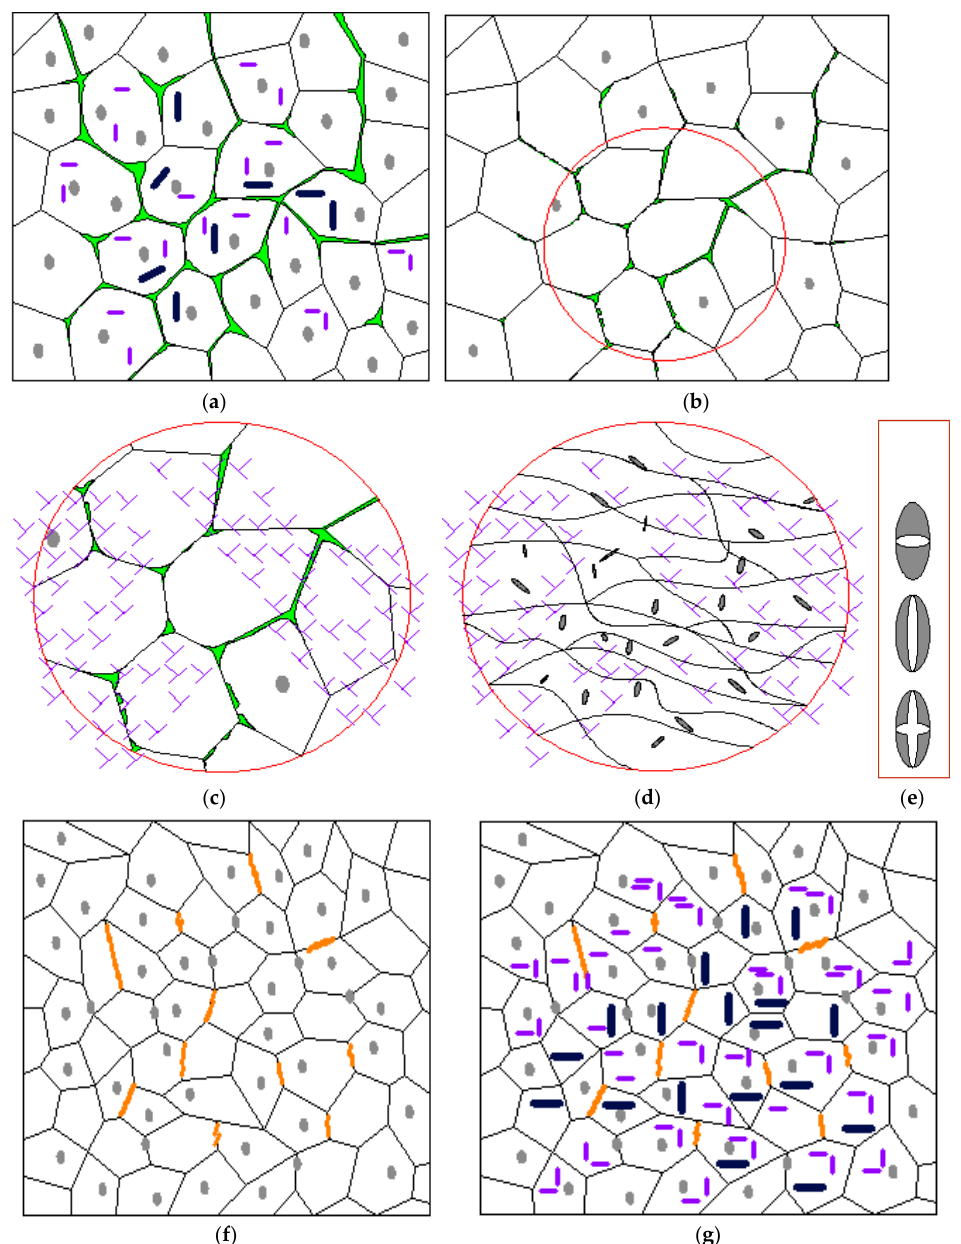
Figure 12. The continuous evolution of the second-phase particles undergoing different processes: ( a ) Ingot; ( b ) homogenization; ( c – e ) MDF; ( f ) solution treatment followed by water quenching; ( g ) peak aging treatment.